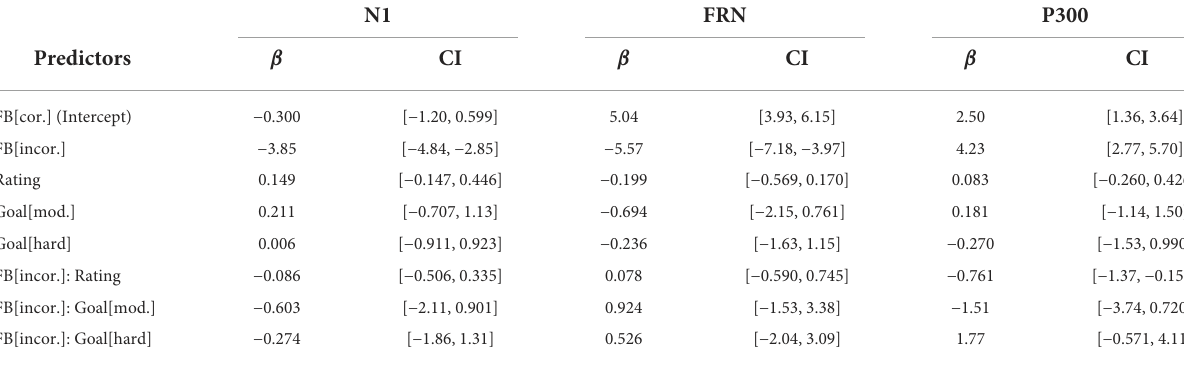
TABLE 4 Estimated coefficients ( β ) and the 95% confidence interval in the linear mixed-effects models of the mean amplitudes of event-related potentials. N1 FRN P300 Predictors β CI β